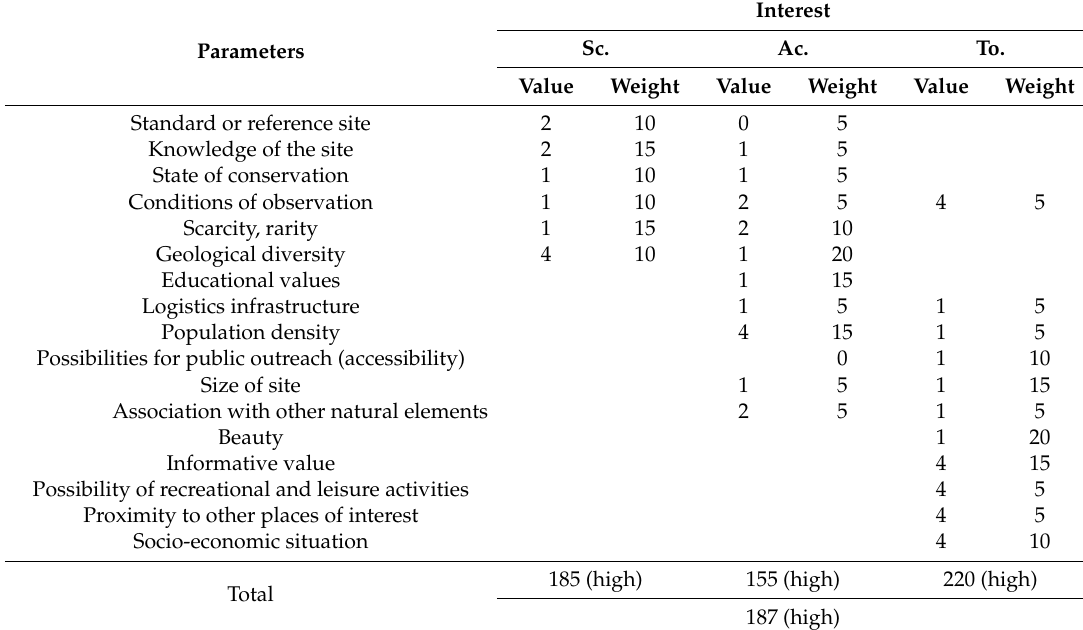
Table 1. Assessment procedure of the scientific (Sc.), academic (Ac.) and touristic (To.) interest of a particular site. The indicated values are a theoretical example. Modified from [33]. Interest value rank (0, 1, 2, 3 or 4). Weight (constant values in %). Interpretation: Maximum (400), Very high (267–400), High (134–266), Medium (50–134), Low